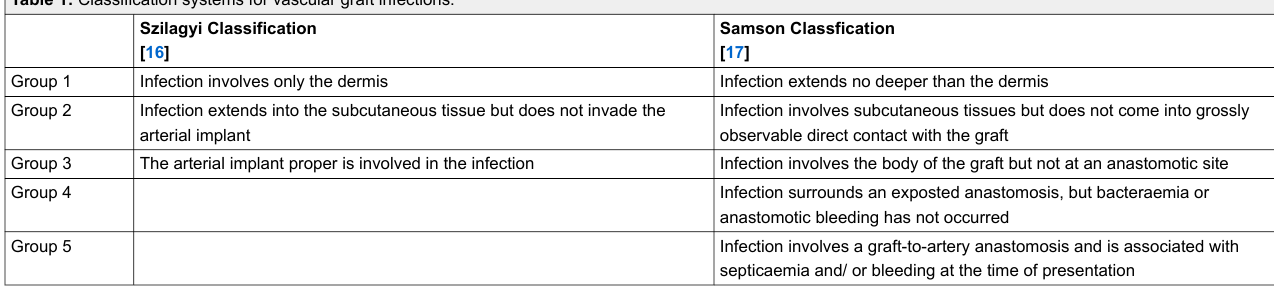
Table 1: Classification systems for vascular graft